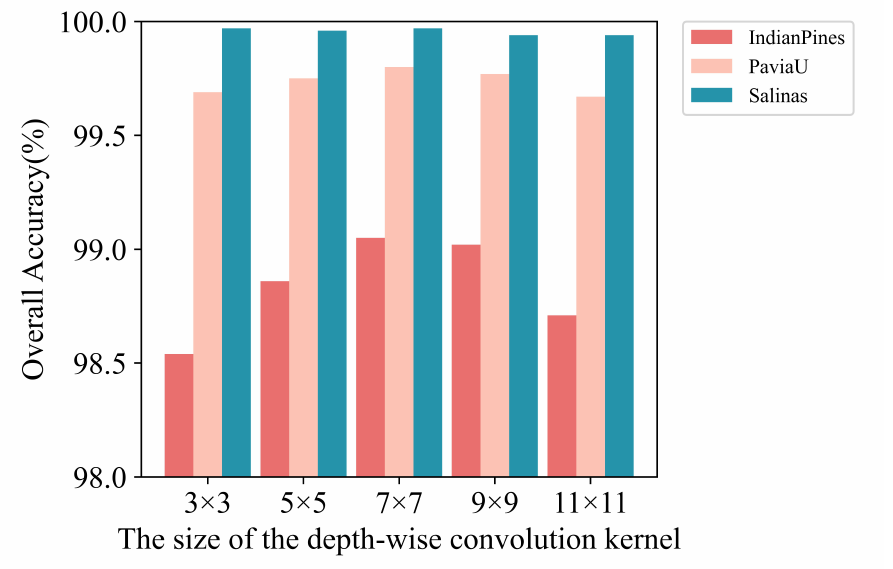
Figure 11. The OAs for the three datasets with different depth-wise convolution kernel sizes in the Res-SEConv